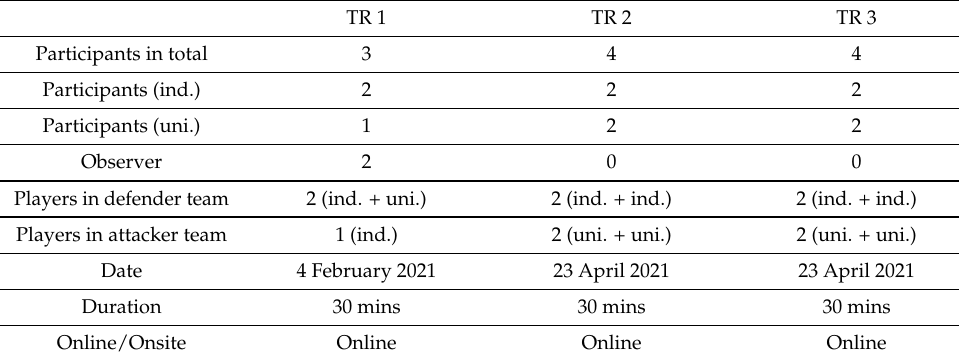
Table 2. Details of each trial runs: TR 1, 2 and 3. ind. = Industry; uni. =